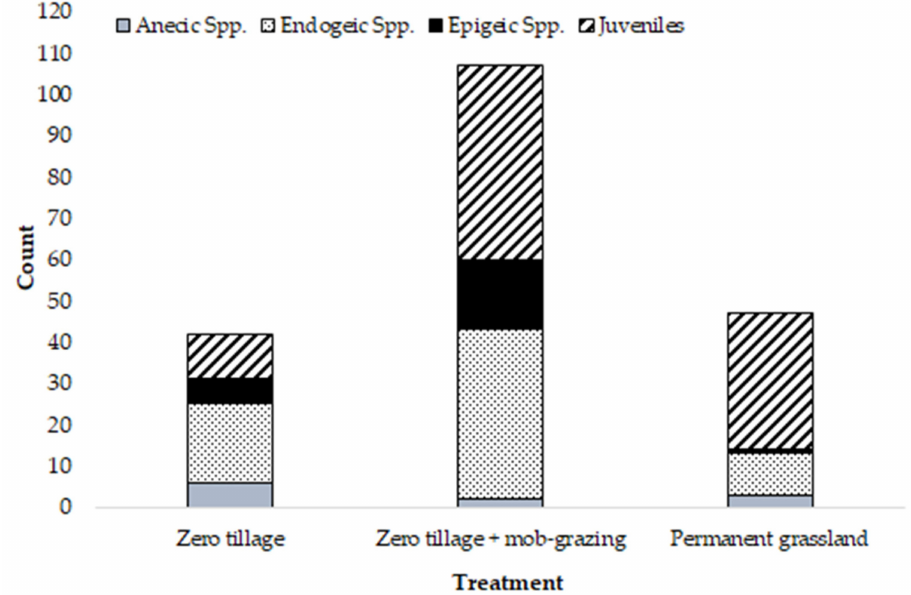
Figure 1. Counts of earthworm functional group for three treatments (ZT: zero tillage; ZTMG: zero tillage + mob-grazing; PG: permanent grassland), n = 10 per treatment.